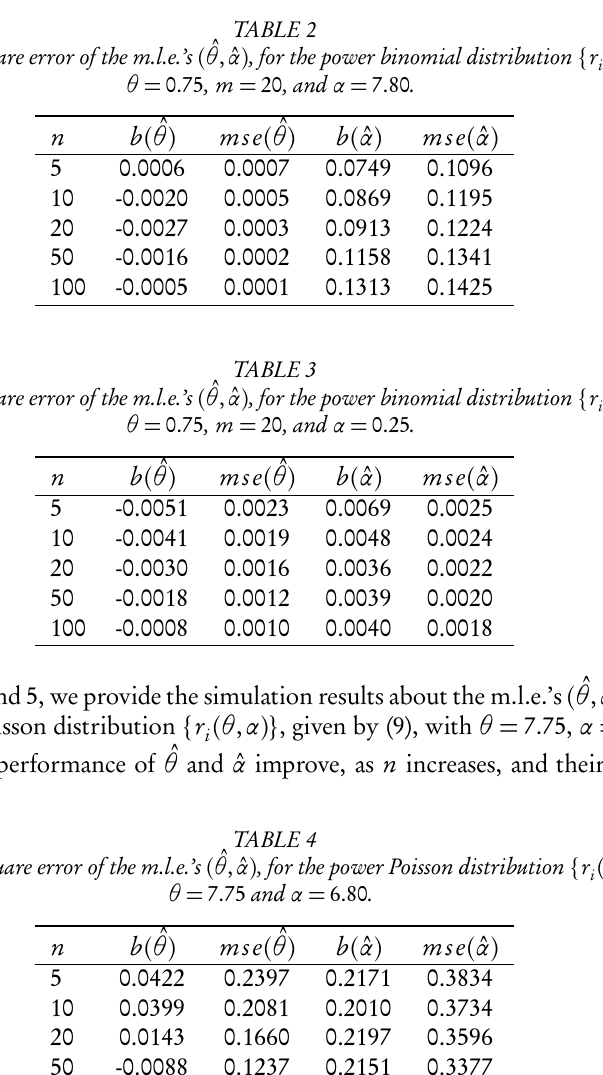
Bias and mean square error of the m.l.e.’s ( ˆ θ , ˆ α ) , for the power binomial distribution { r